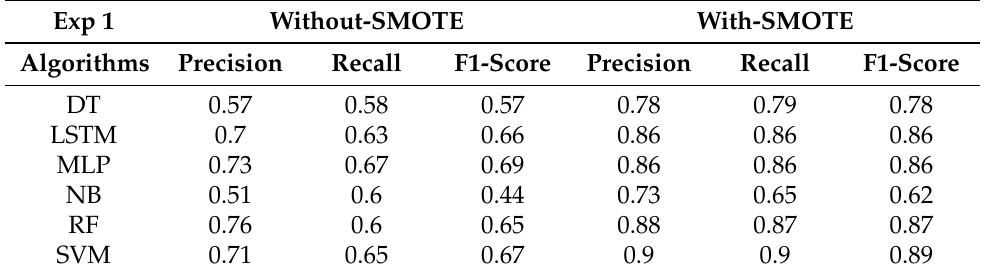
Table 2. Exp1 Scores (Precision, Recall, F1-Score).